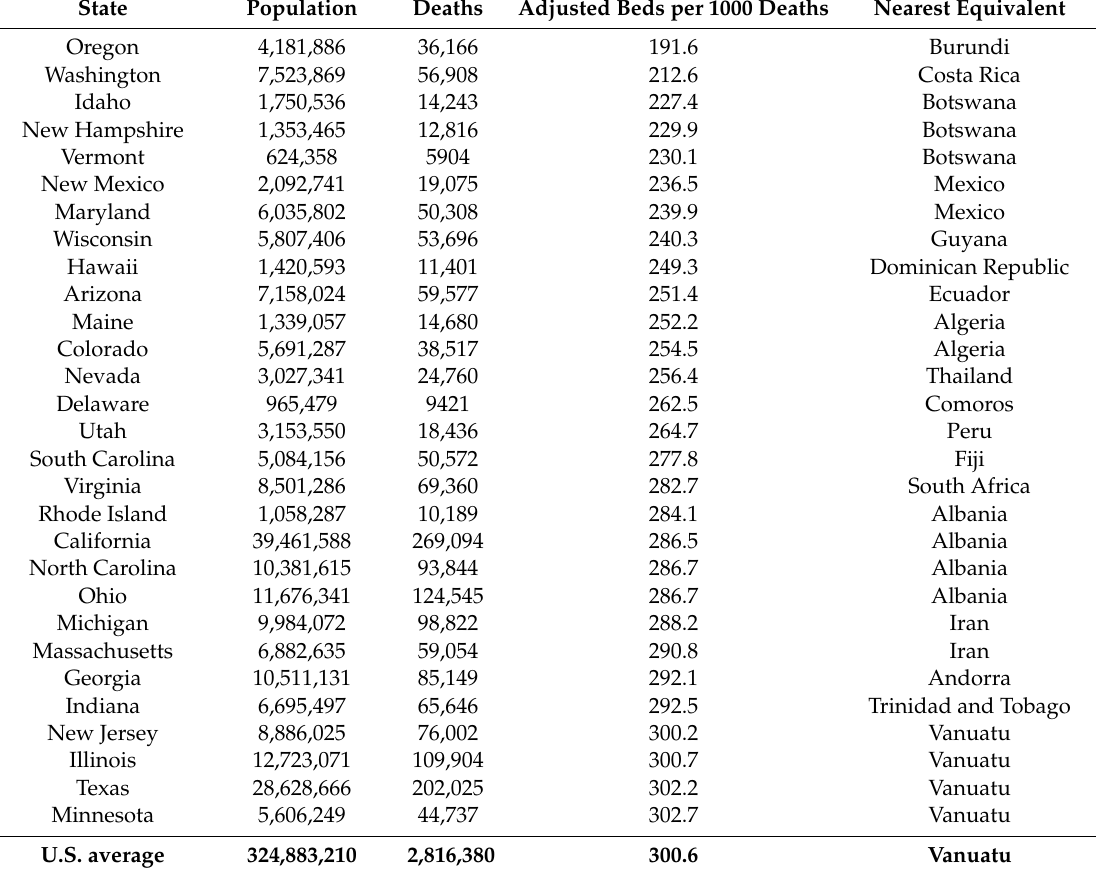
Table 1. U.S. states with the least number of beds and nearest International equivalent, all adjusted to 8.69 deaths per 1000